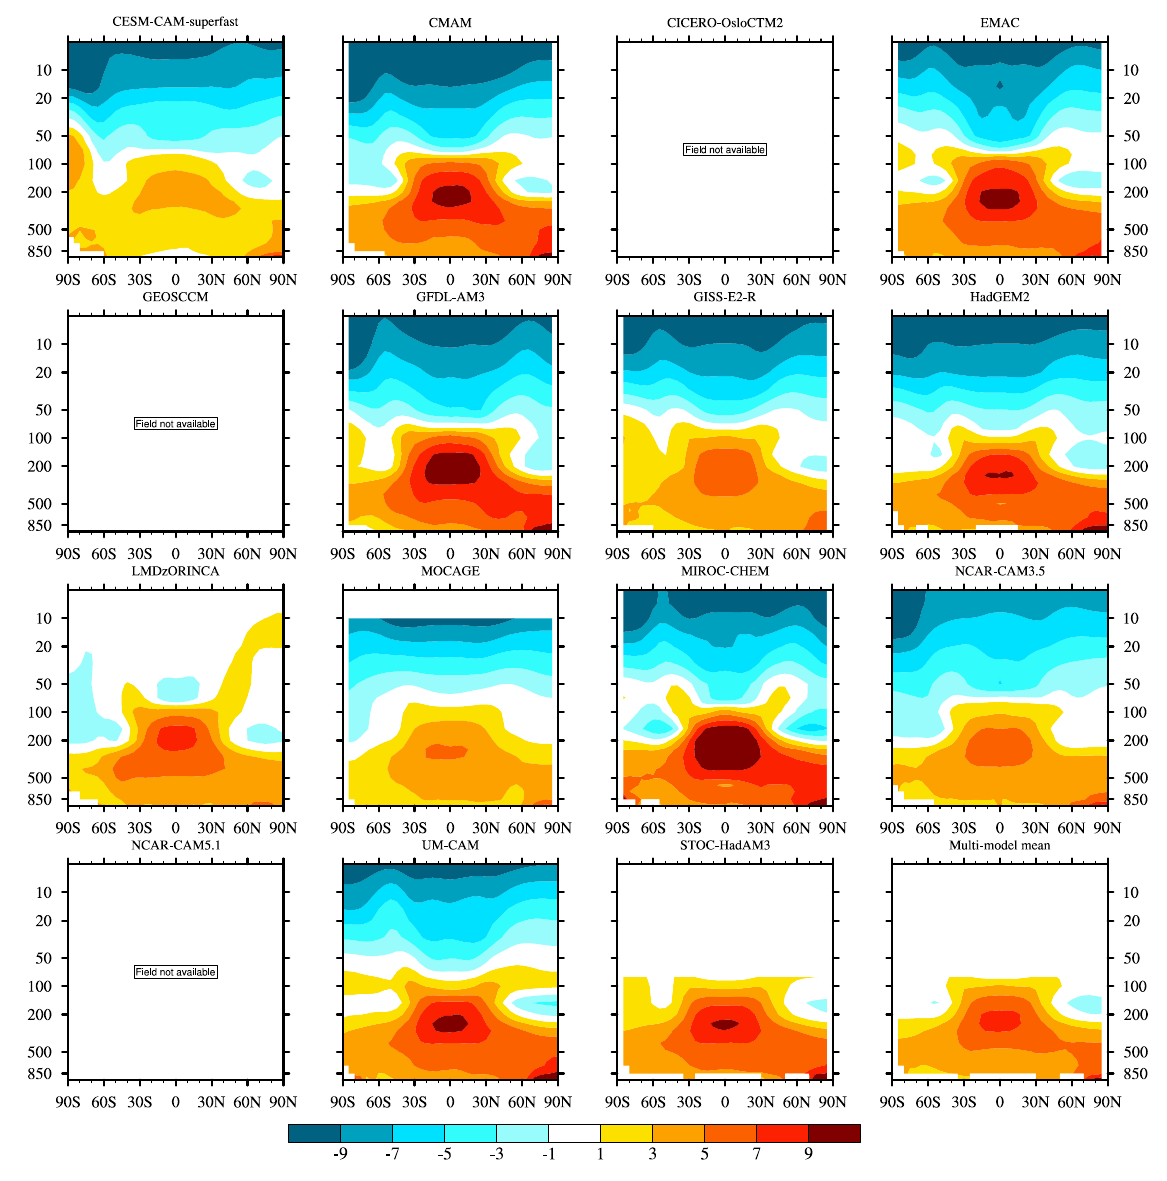
Figure 11c. Same as Figure 11b but for RCP8.5. Fig. 11c. Same as Fig. 11b but for RCP8.5. Fig. 11c. Same as (b) but for RCP8.5. of Earth System interactions and feedbacks (Arneth et al.,